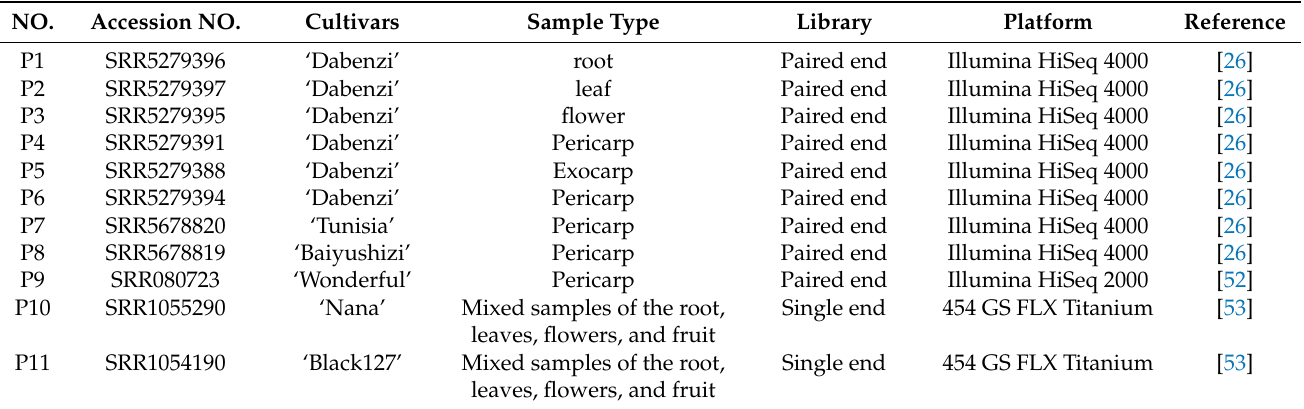
Table 3. RNA-Seq data of pomegranate.